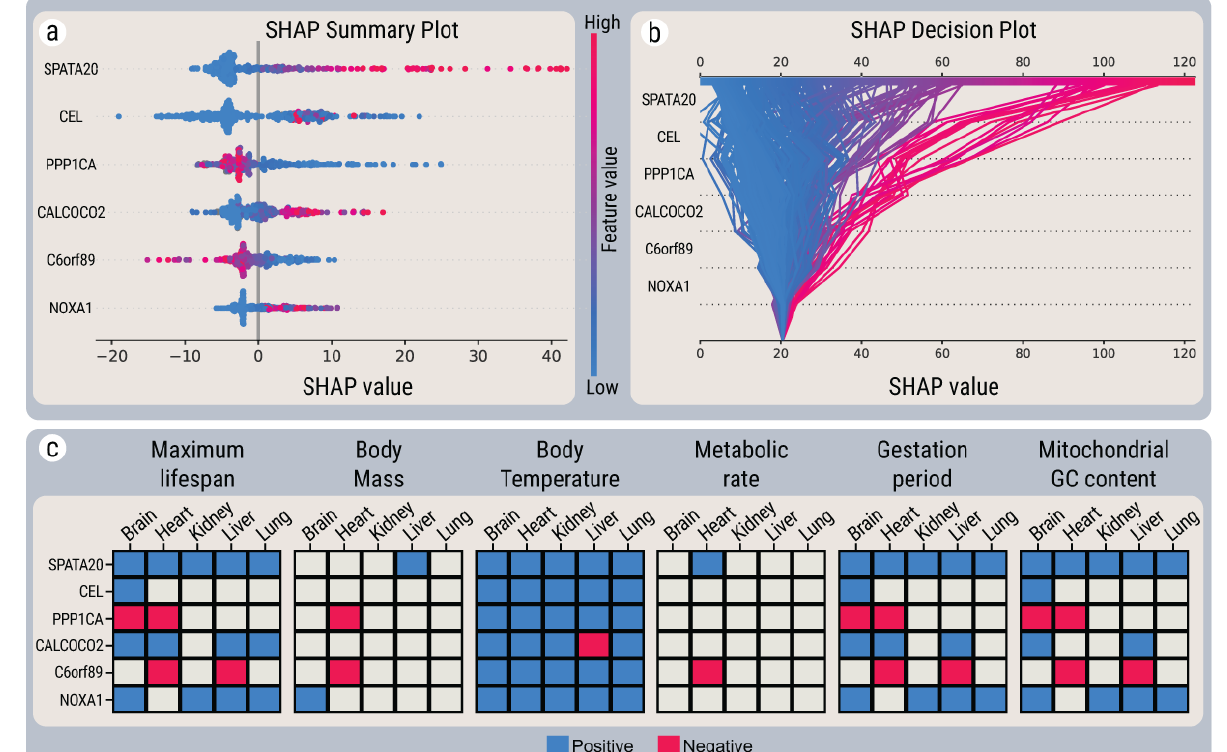
Figure 4. Expression signature of the top six genes in a multi-model analysis. ( a ) SHAP summary plot of the impact of the six most predictive genes of the MLS, based on their expression levels. Each dot represents an individual sample in the model, where its X -axis position is an impact (in years) on the MLS prediction of the model in the sample. Colors show the expression of a particular gene in comparison to its baseline expression level across all samples: from blue (lower) to red (higher). The genes are sorted in decreasing order based on the feature importance (average of the absolute value of impacts). ( b ) SHAP decision plot with interactions. Each sample’s MLS prediction is represented by a colored line. At the top of the plot, each line strikes the X -axis at its corresponding predicted MLS value, which also defines the color of the line on a spectrum. Unlike in regular decision plot interactions, effects between pairs of genes are included. At the bottom of the plot, the lines approach the base value of 21.3. Moving from the bottom of the plot to the top, SHAP values for each feature are added to the model’s base value of 21.3 years. This shows how each gene contributes to the MLS prediction in a layer-wise propagation manner. ( c ) Linear correlations for species features and gene expressions of the six most predictive genes. The heatmap represents significant statistical associations ( FDR < 0.05, R 2 > 0.3) between the expression levels of the six genes with MLS and other life-history traits, in different